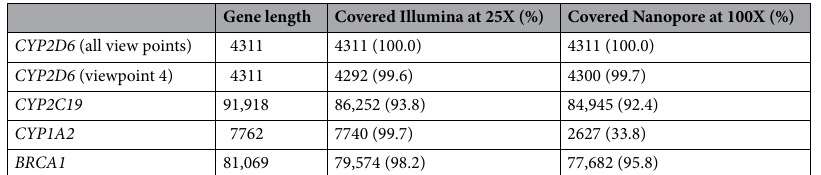
Gene length Covered Illumina at 25X (%) Covered Nanopore at 100X (%) CYP2D6 (all view